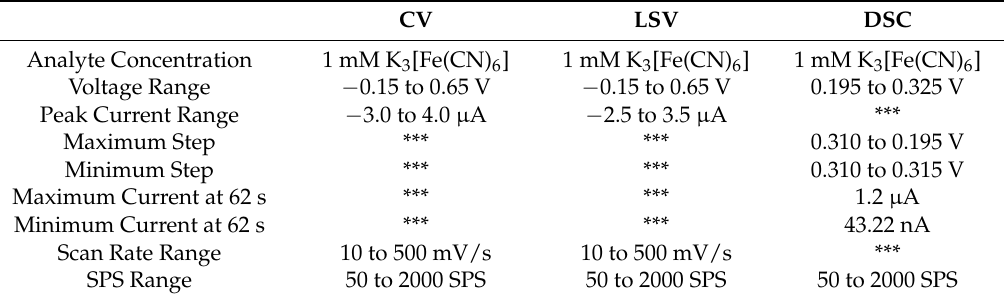
Table 9. Electrochemical conditions evaluated. *** Data did not evaluate in the study.